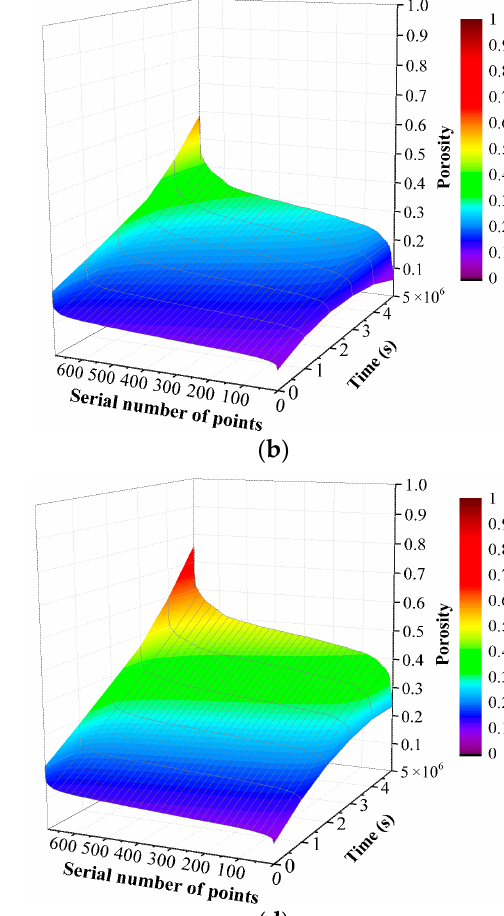
Figure 5. The porosity values at 692 points at di ff erent times and pH values ( k w = 2): ( a ) pH = 6.6; ( b ) pH = 6; ( c ) pH = 5; ( d ) pH =